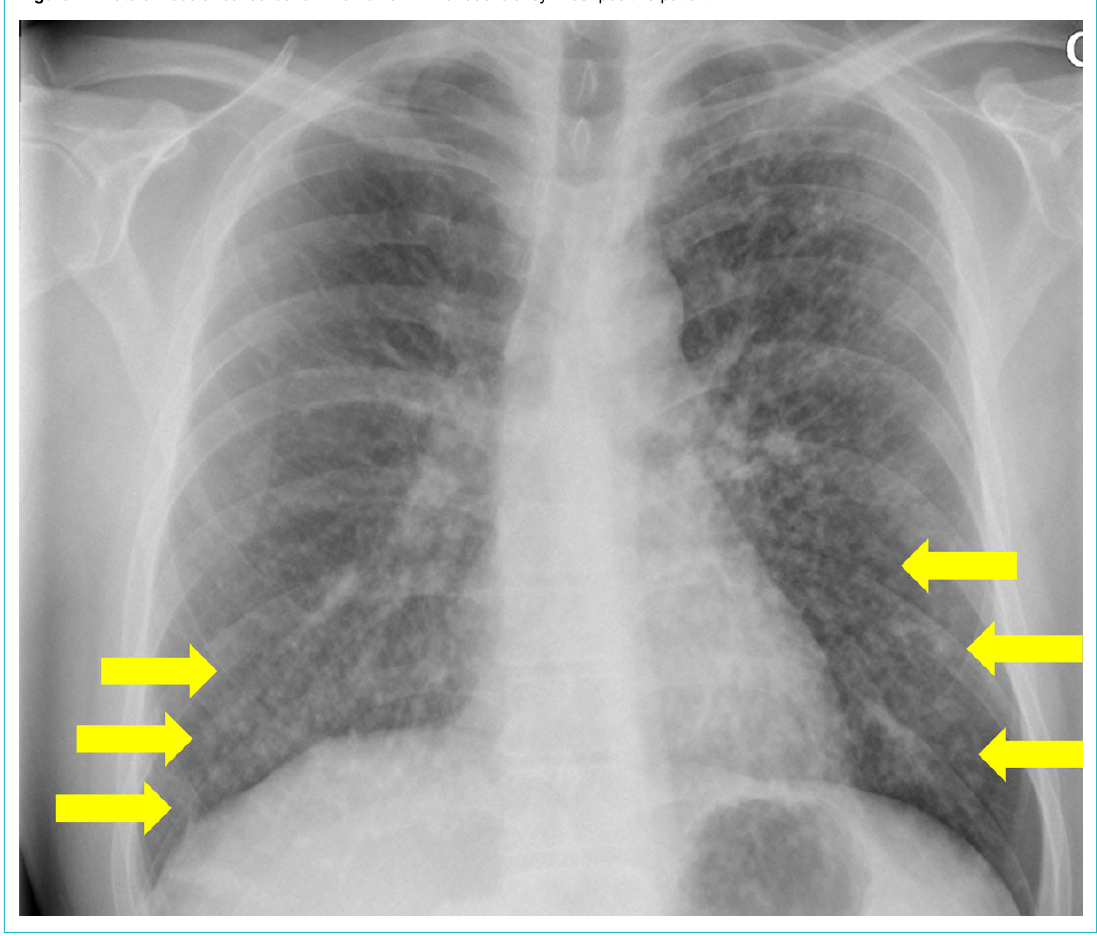
Figure 4: Bilateral nodular consolidation in a human immunodeficiency virus -positive